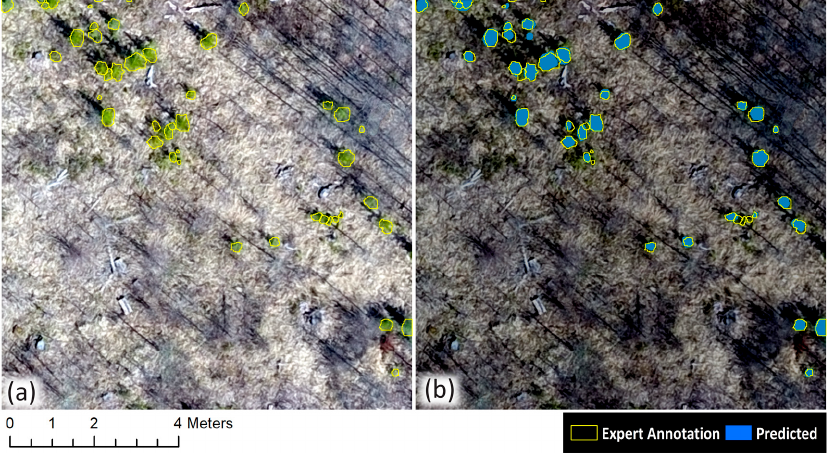
Figure 5. External Validation Tile b (B21). Annotated ground truth ITC are displayed yellow in both panels. The original image is displayed in ( a ). Predicted ITC are displayed in blue ( b ).